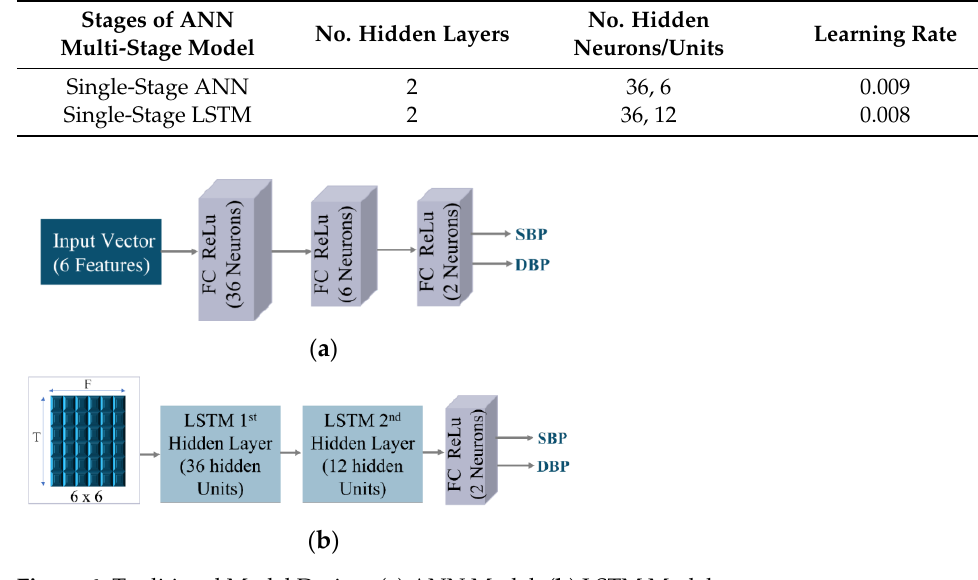
Figure 6. Traditional Model Design. ( a ) ANN Model. ( b ) LSTM Model. The loss metric Mean Absolute Error (MAE) was calculated using